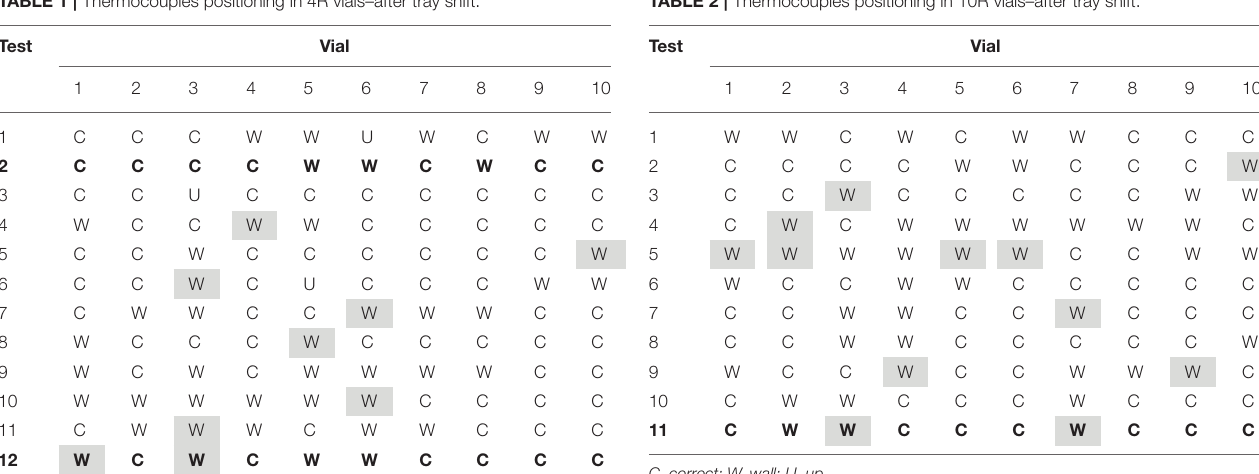
TABLE 2 | Thermocouples positioning in 10R vials–after tray